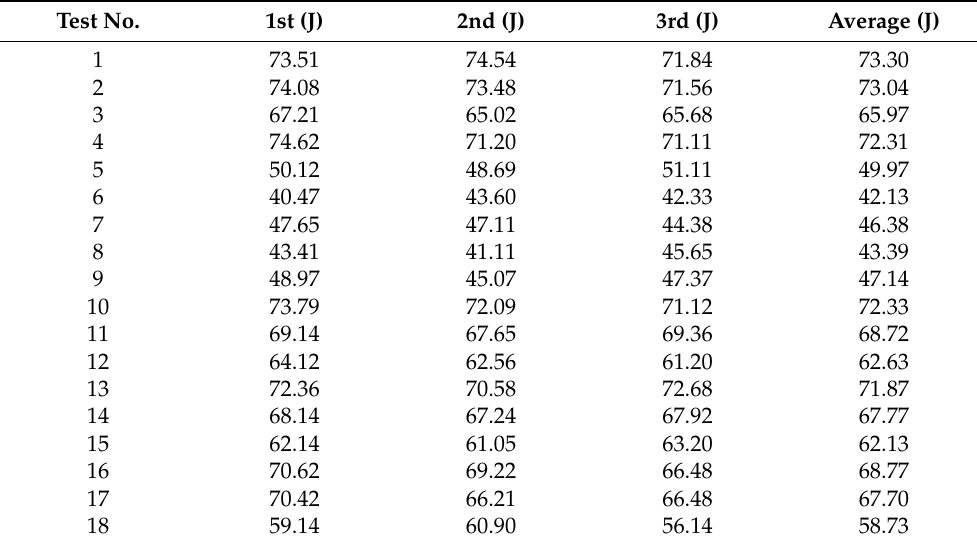
Table 5. Results of Charpy impact test according to flux core arc welding.